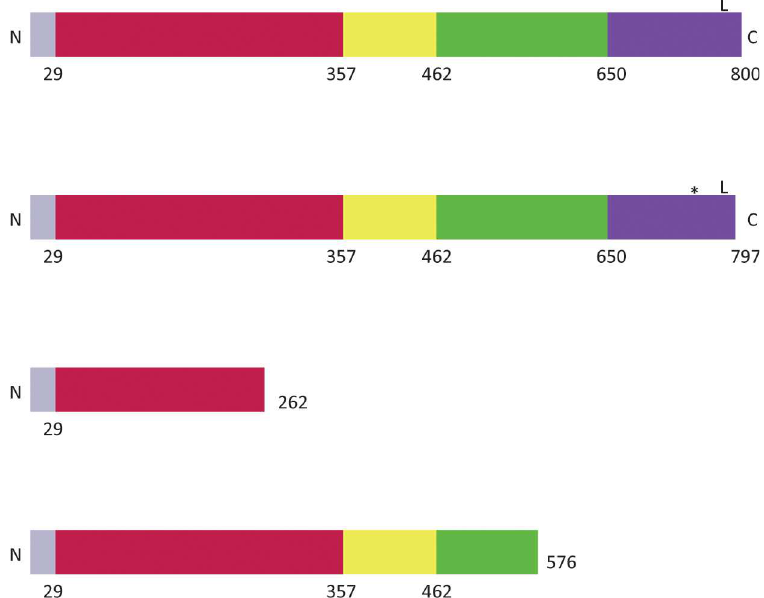
Fig 2. Lengths of predicted InlA proteins with functional regions labeled. The N and C termini are labeled.The final number of the right of each construct is the predictedlengthsof the proteins. The InlA protein is dividedinto 5 regions with the first 29 amino acids (gray region)encodinga SignalSequence. Amino acids 30–357(red) encode a leucinerich repeat neededfor attachmentto the E-cadherinreceptor. Amino acids 358–462(yellow)encode an intergenicrepeat. Amino acids 463–650(green)encodethe B repeats section, and amino acids 651–800encode the MembraneAnchor region. An “L” on the MembraneSpanning regionof the top two constructs indicatewhere the LPXTG motif is located. The regionthat is deletedin the 797-amino acid protein in relationto the full-lengthprotein is indicatedby an asterisk ( * ).